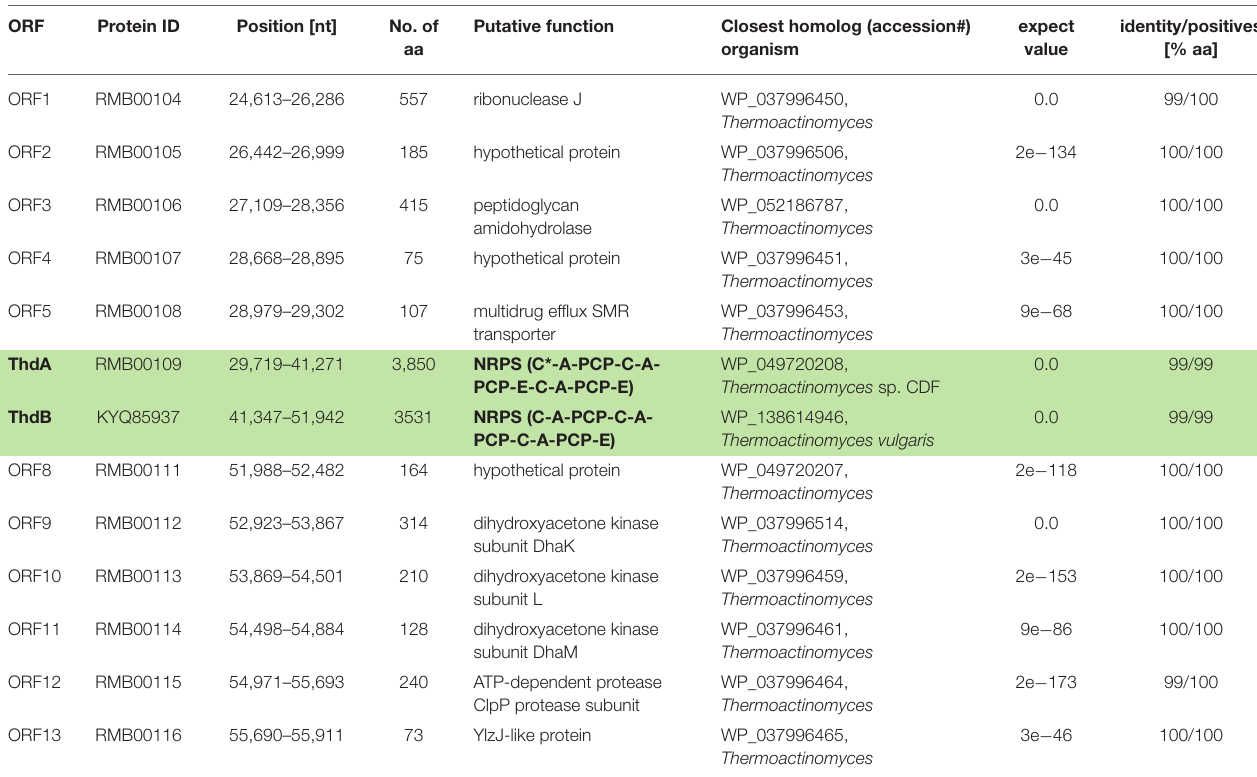
TABLE 1 | Putative genes identified on the de novo assembled contig containing the thermoactinoamide gene cluster (highlighted in green and bolded) from T. vulgaris DSM 43016. ORF Protein